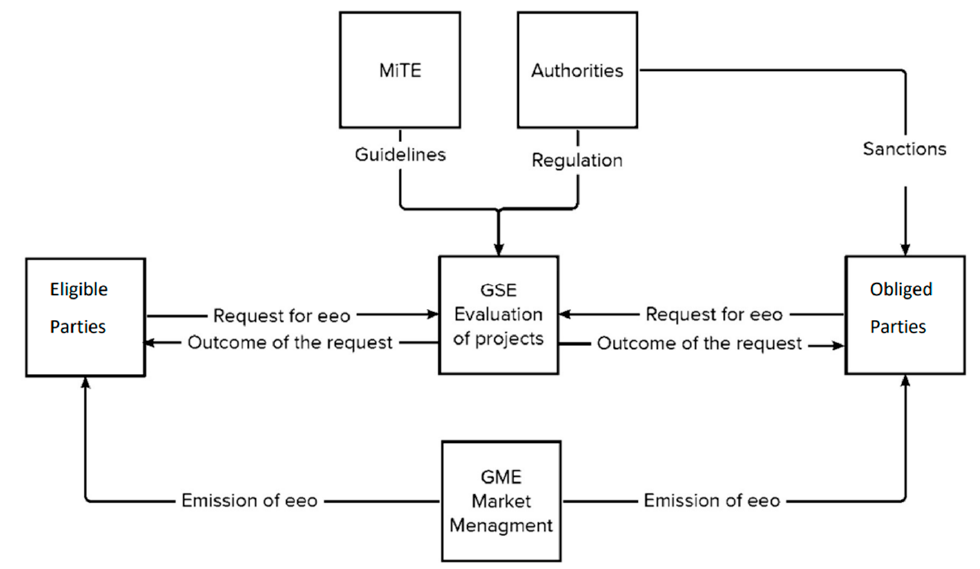
Figure 1. Actors involved in the White Certi fi cate mechanism.